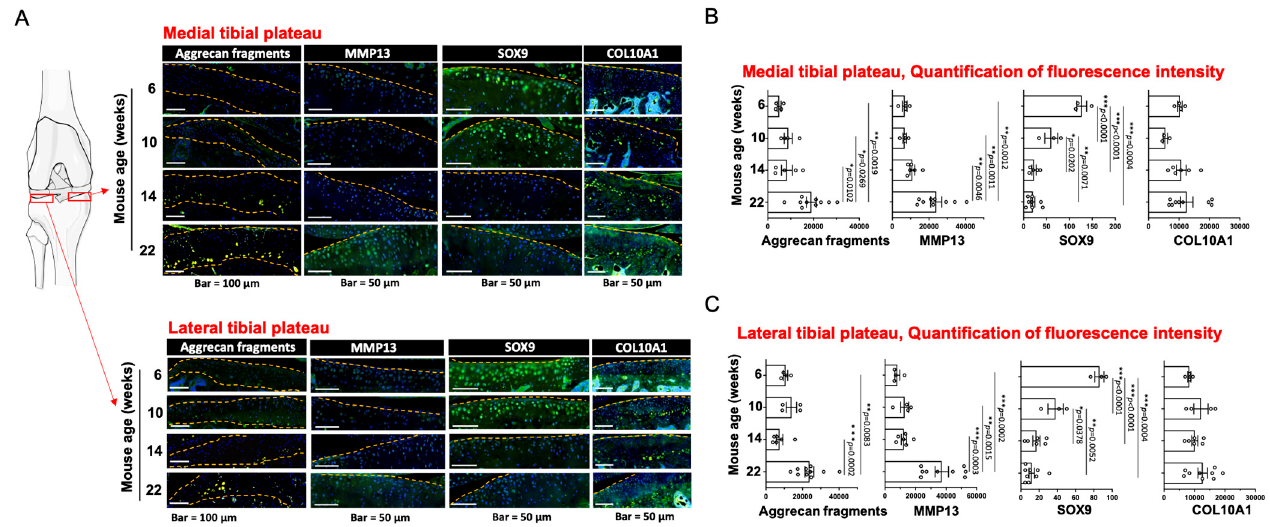
Figure 2. Changed expression level of OA markers associated with age is detected in articular cartilage. ( A ) Representative images of aggrecan fragments, MMP-13, Sox9, and COL10A1 IF staining (green) in whole articular cartilage from STR/ort mice with indicated weeks old. DAPI (blue) stains nuclei; yellow dashed lines define the cartilage region. ( B ) Quantification of fluorescence in the region of whole articular cartilage in MTP. ( C ) Quantification of fluorescence in the region of whole articular cartilage in LTP. Abbreviations: MTP, medial tibial plateau; LTP, lateral tibial plateau; Sox9, SRY-box transcription factor 9; MMP-13, Matrix metalloproteinase-13; COL10A1, collagen type X alpha 1 chain.